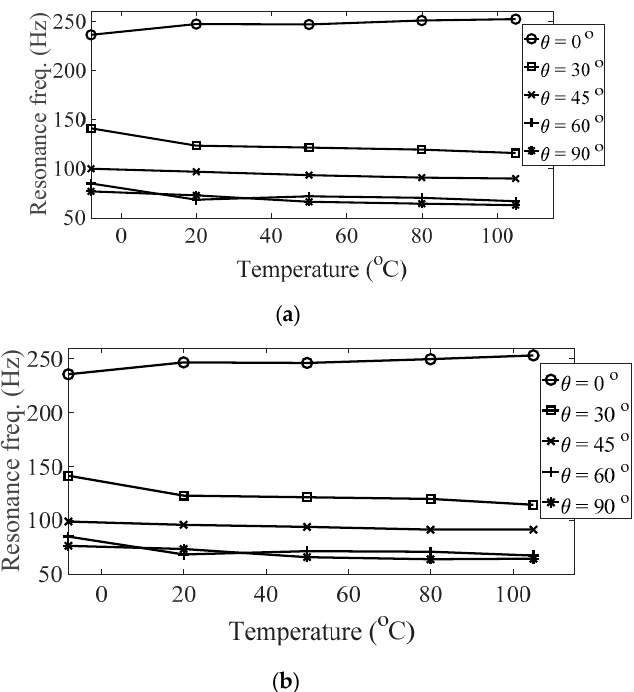
Figure 10. Variation of resonance frequency ( ω n ,1 ) according to different temperature conditions: ( a ) p = harmonic and ( b ) p = random.